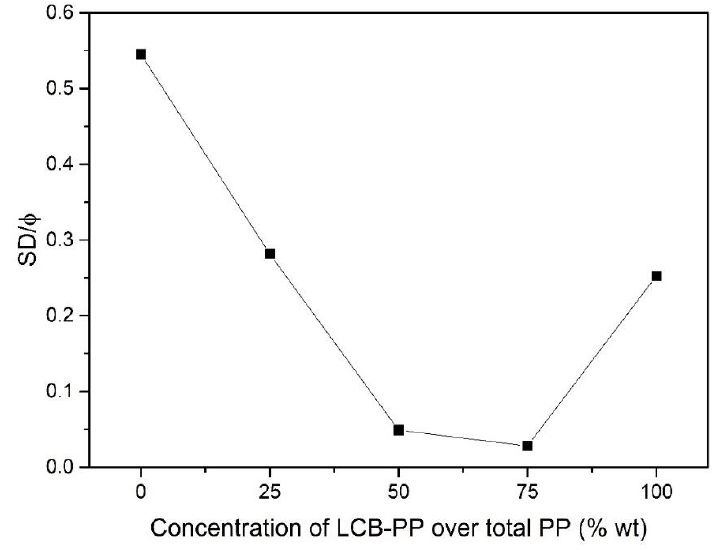
Figure 4. SD / φ parameter as a function of LCB-PP Figure 4. SD/ϕ parameter as a function of LCB-PP concentration.